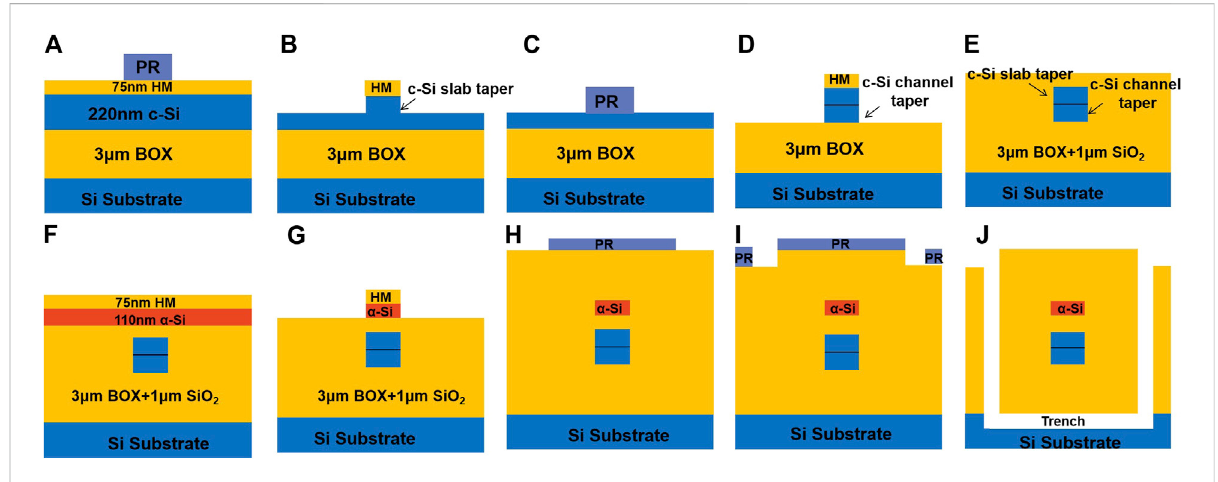
FIGURE 5 Process fl ow of edge-coupler. (A) Pattern mask 1, (B) Partially etch SiO 2 /c-Si, (C) Pattern mask 2, (D) Etch c-Si to BOX, (E) Deposited SiO 2 layer, (F) Deposited α -Si layer and HM layer, (G) Partially etch SiO 2 /c-Si, (H) Pattern mask 3, (I) Pattern mask 4 (J) etch SiO 2